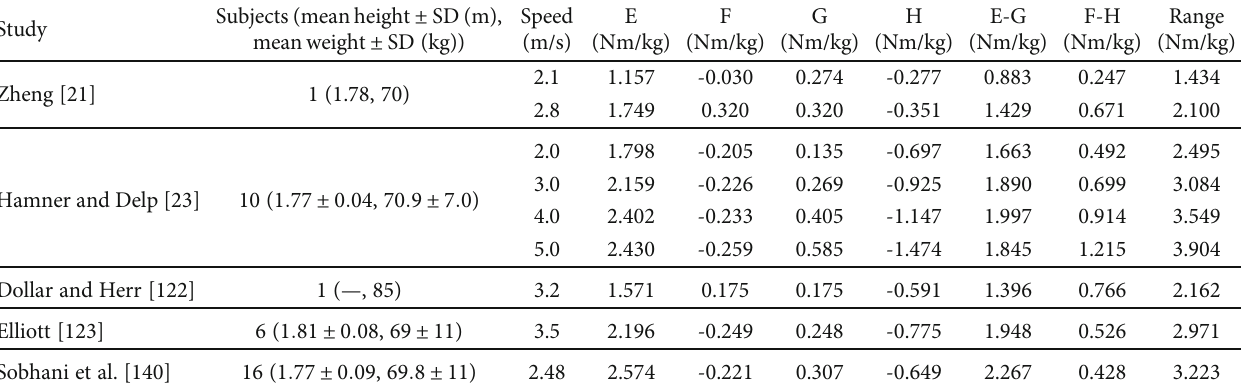
Table 5: Overview over the experimental results of knee moment for running.